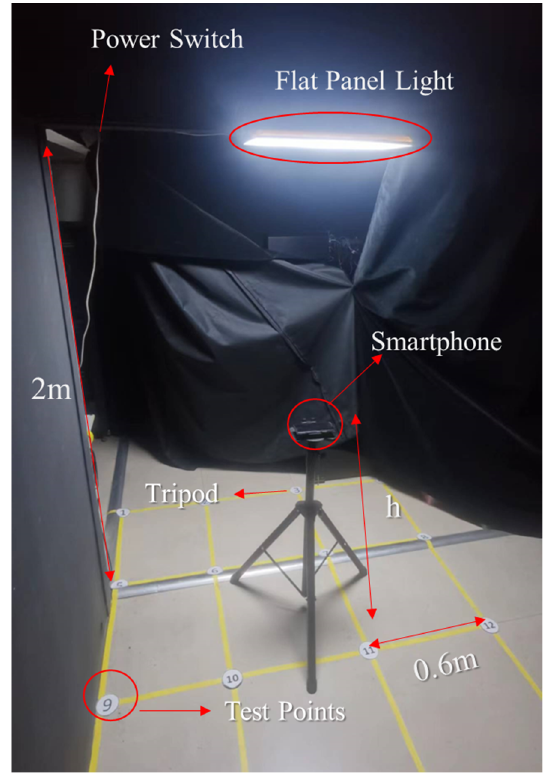
Figure 12. Experimental setup of the LP-VLP system.